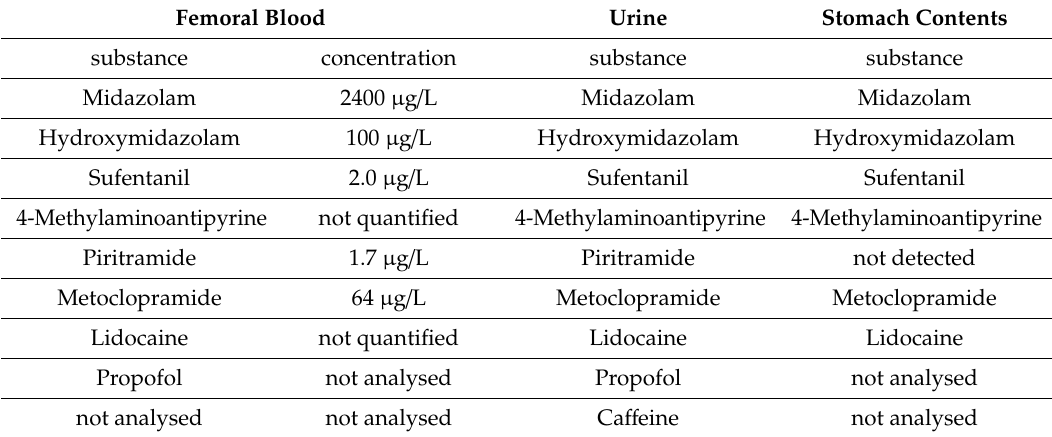
Table 4. Substances detected in femoral blood, urine and stomach contents of case 1.